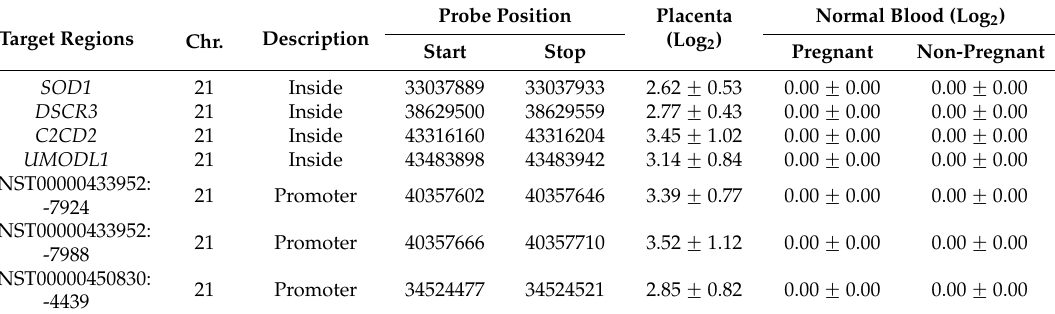
Table 2. Methylation levels of selected regions according to tissue type.